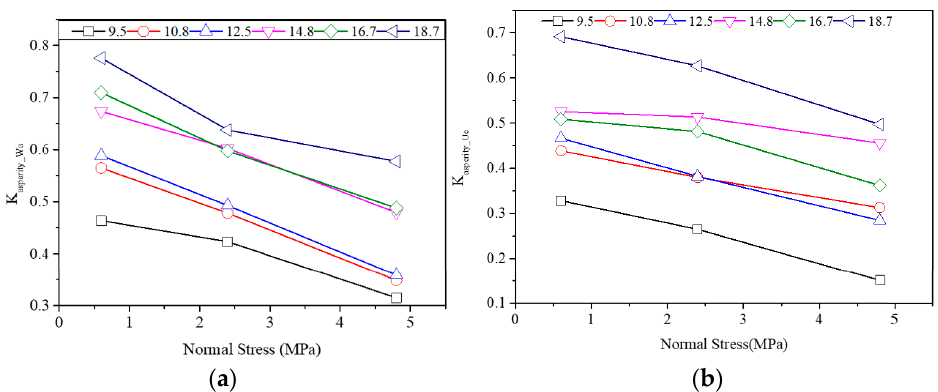
Figure 13. ( a ) Mechanical contribution of waviness, ( b ) Mechanical contribution of unevenness.